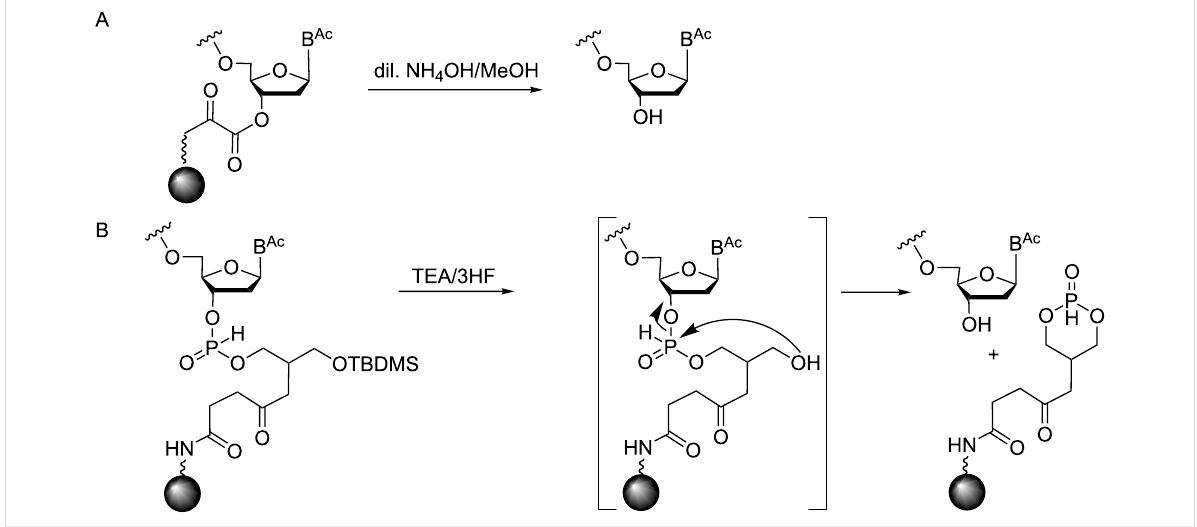
Figure 5: Release of trinucleotide blocks from the solid support by cleavage of an oxalyl anchor (A) and by a transesterification mechanism (B).